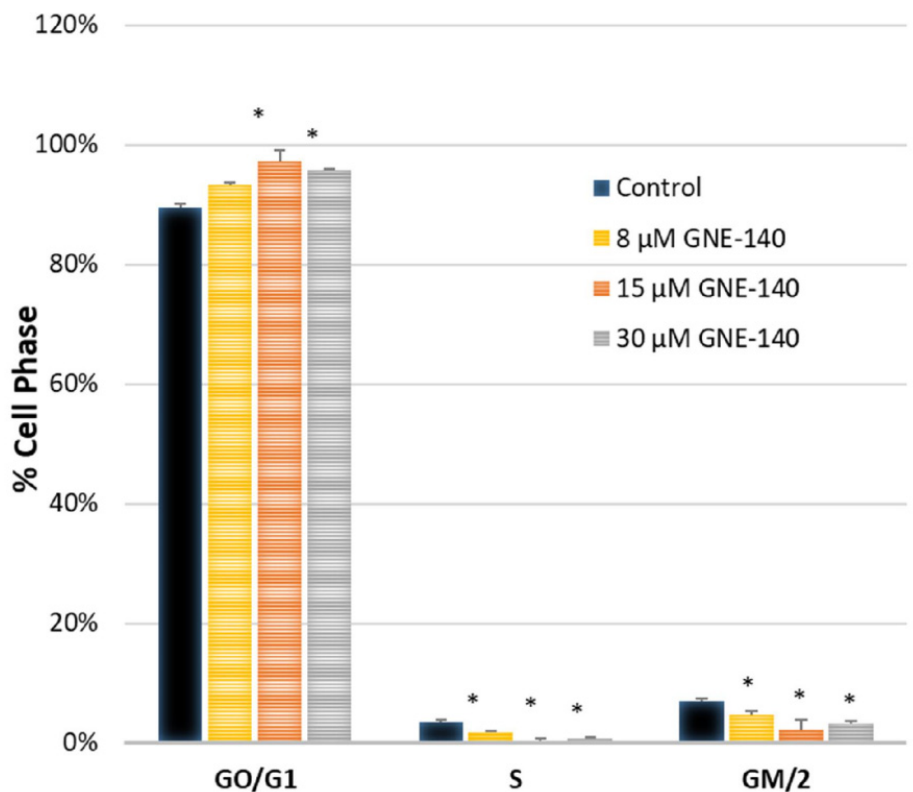
Figure 12. Digital cell cycle analysis in GNE-140-treated MDA-MB-231 cells was performed using fluorescence cytometry. The data represents the average ± the mean of cells at various stages, as a % of total cell cycle phases, n = 3. The significance of differences between the groups was determined by a one-way ANOVA with Tukey’s post-hoc test. * p < 0.05.